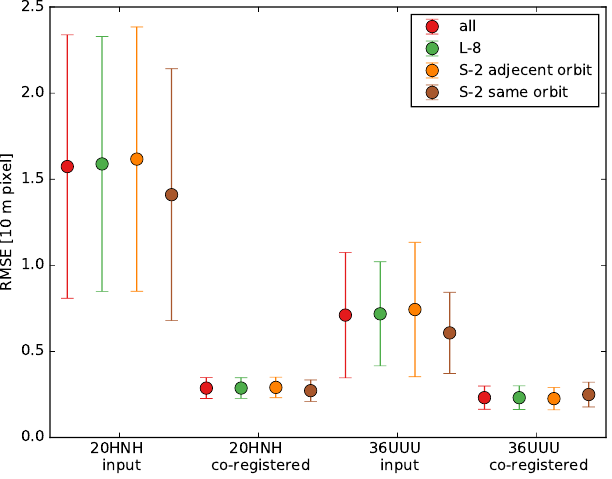
Figure 2. RMSEs before and after co-registration at two test sites in Argentina (20HNH) and Ukraine (36UUU). (note, L-8: Landsat-8; S-2: Sentinel-2).